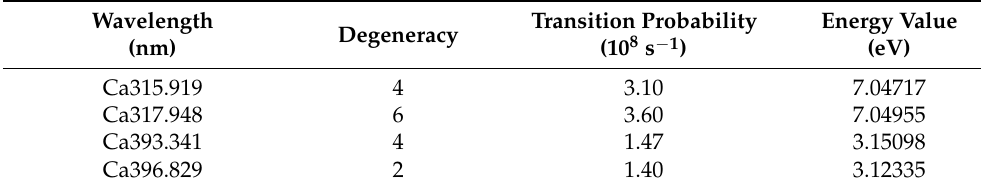
Table 3. The plasma temperatures of the fourteen standard pulverized coals.